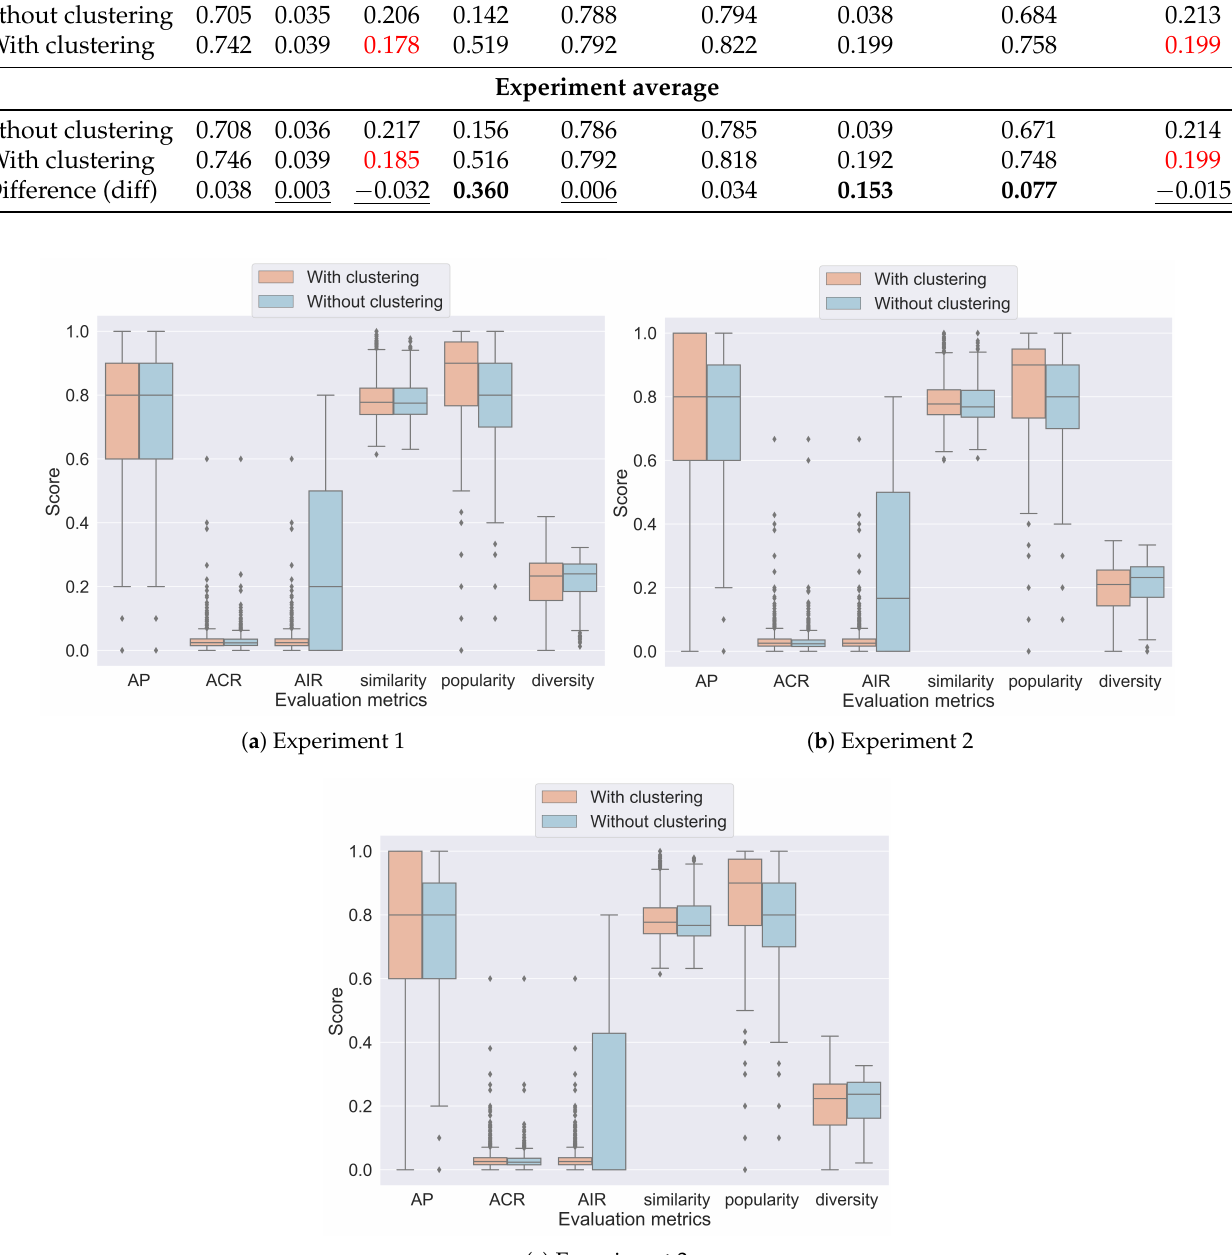
Figure 7. Box plots of precision , recall , similarity , popularity and diversity metrics for the test set in each